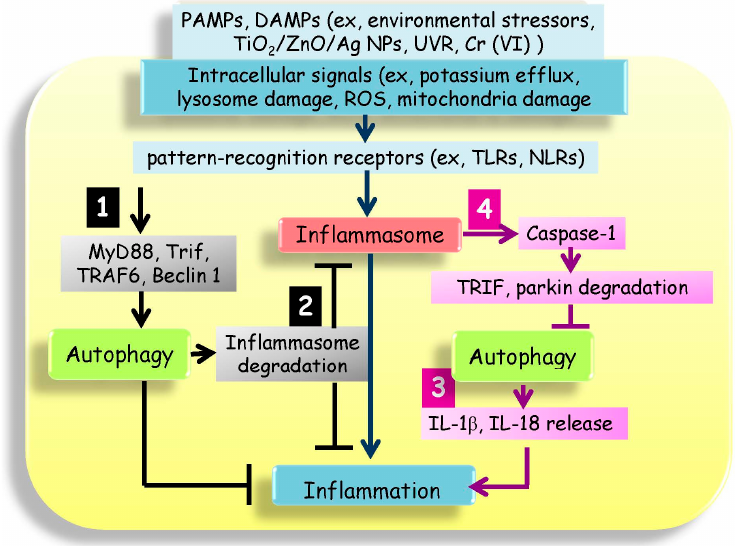
Scheme 1. The mutual regulation mechanisms of autophagy and the inflammasome. In response to PAMPs, DAMPs (such as TiO 2 /ZnO/Ag NPs, UVR and Cr(VI)), and cellular signaling such as potassium efflux, lysosome damage, and release of mitochondrial ROS, PRRs including TLRs